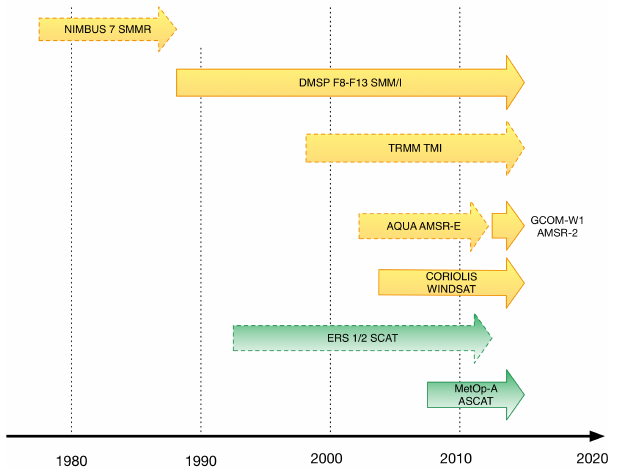
Figure 1. Satellites and sensors used for generating the offline ESA CCI SM dataset and the daily continuation via ASCAT and AMSR2. Dotted lines indicate inactive missions, yellow arrows rep- resent passive measurements, green arrows represent active mea- surements. The ESA CCI SM dataset only includes SSM/I data until 2007.